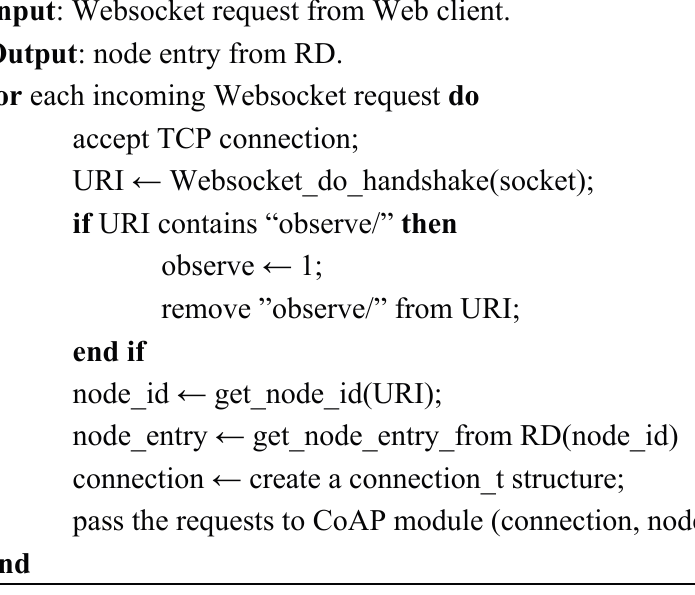
Algorithm 1. The Web server module receives a Websocket request, checks its validity and passes it to the CoAP